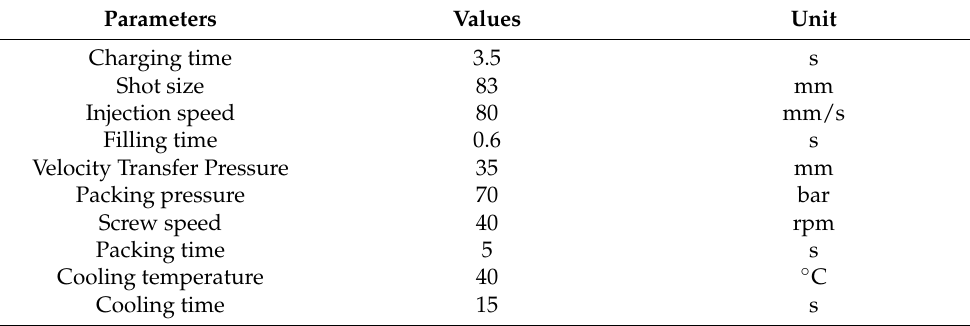
Figure 2. Production steps of hybrid fiber overmolded composite. Table 2. Non-variable parameter setting.